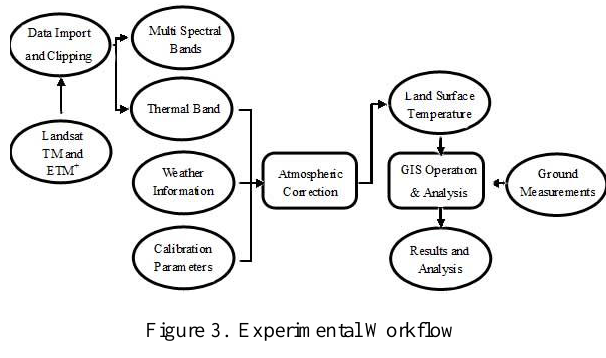
Figure 5. Comparison of LST and the Air Temperature for the